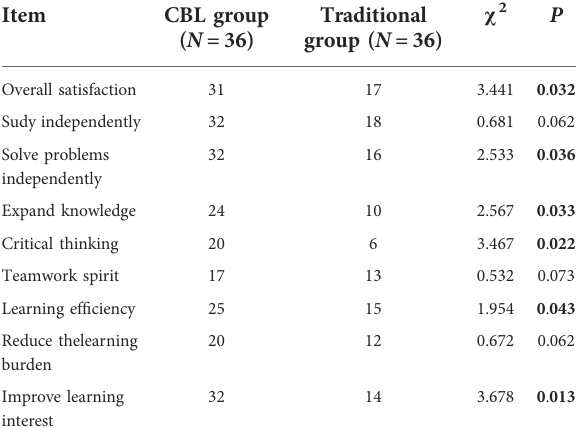
TABLE 4 Students ’ questionnaire survey results.